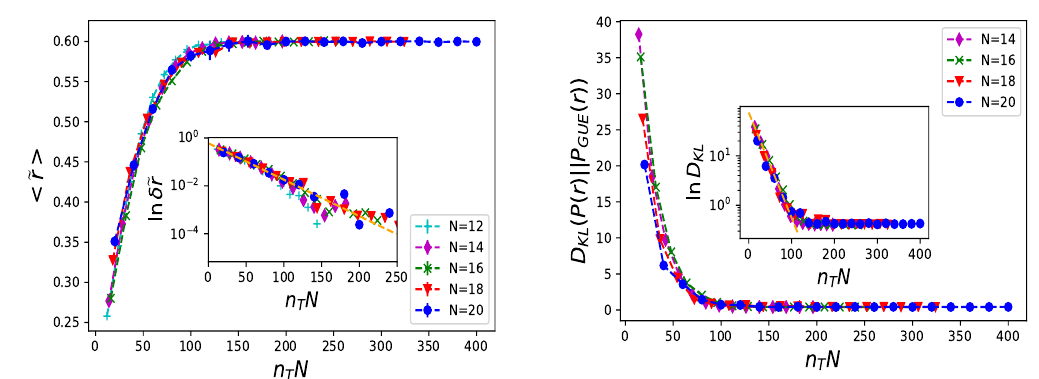
Figure 4: Finite-size scaling of the infinite-time ES. Left : The infinite-time average r ( τ → ∞ ) 〉 versus n N , for system sizes N = 10,12,14,16,18 level spacing ratio 〈 (cid:101) T r ( τ → ∞ ) 〉 = f ( n N ) and 20. All curves collapse to a universal scaling function 〈 (cid:101) T ≈ 0.39 and ≈ 0.6. Inset: deviations from r r r interpolating between (cid:101) (cid:101) (cid:101) Poisson GUE GUE r ≈ r e − γ n T N . Right : in log-linear scale, indicating the exponential scaling form δ (cid:101) (cid:101) 0 The KL divergence between the full ES level spacing distribution and the W-D distri- bution. D for different curves also collapses to a universal scaling function of the KL N . Inset: D N , similarly to δ r . The data product n decays exponentially with n (cid:101) T T KL are averaged over 3000 ( N = 10 ) , 2000 ( N = 12 ) , 1500 ( N = 14 ) , 1000 ( N = 16 ) , 500 ( N = 18 ) , and 150 ( N = 20 ) realizations. When not visible, the error-bars are smaller than the size of the data